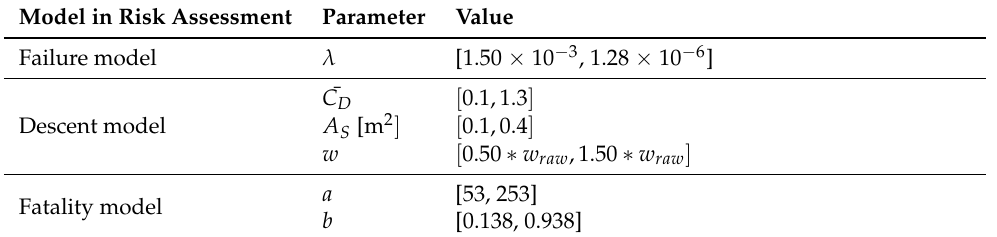
Table 4. Parameters in risk assessments and their values for sensitivity analyses.